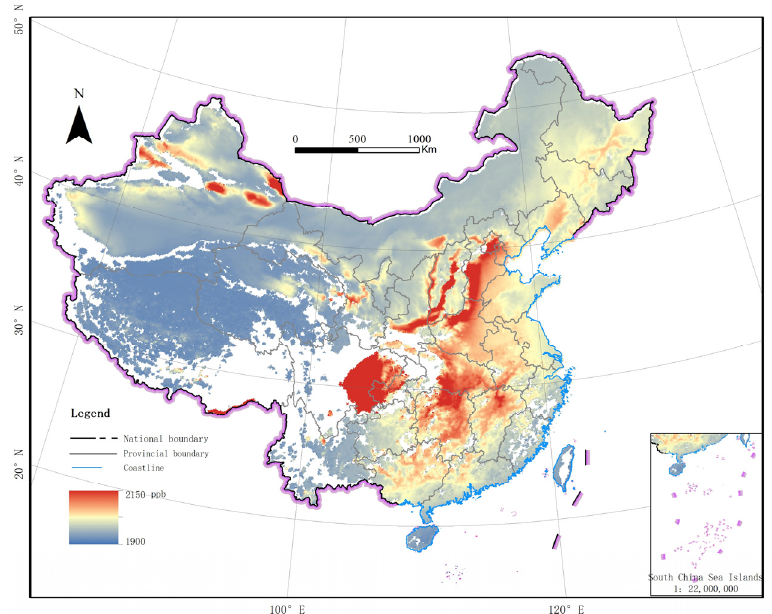
Figure 2. Surface spatial distribution of multi-year averages of atmospheric XCH 4 over China from January 2019 to September 2022.